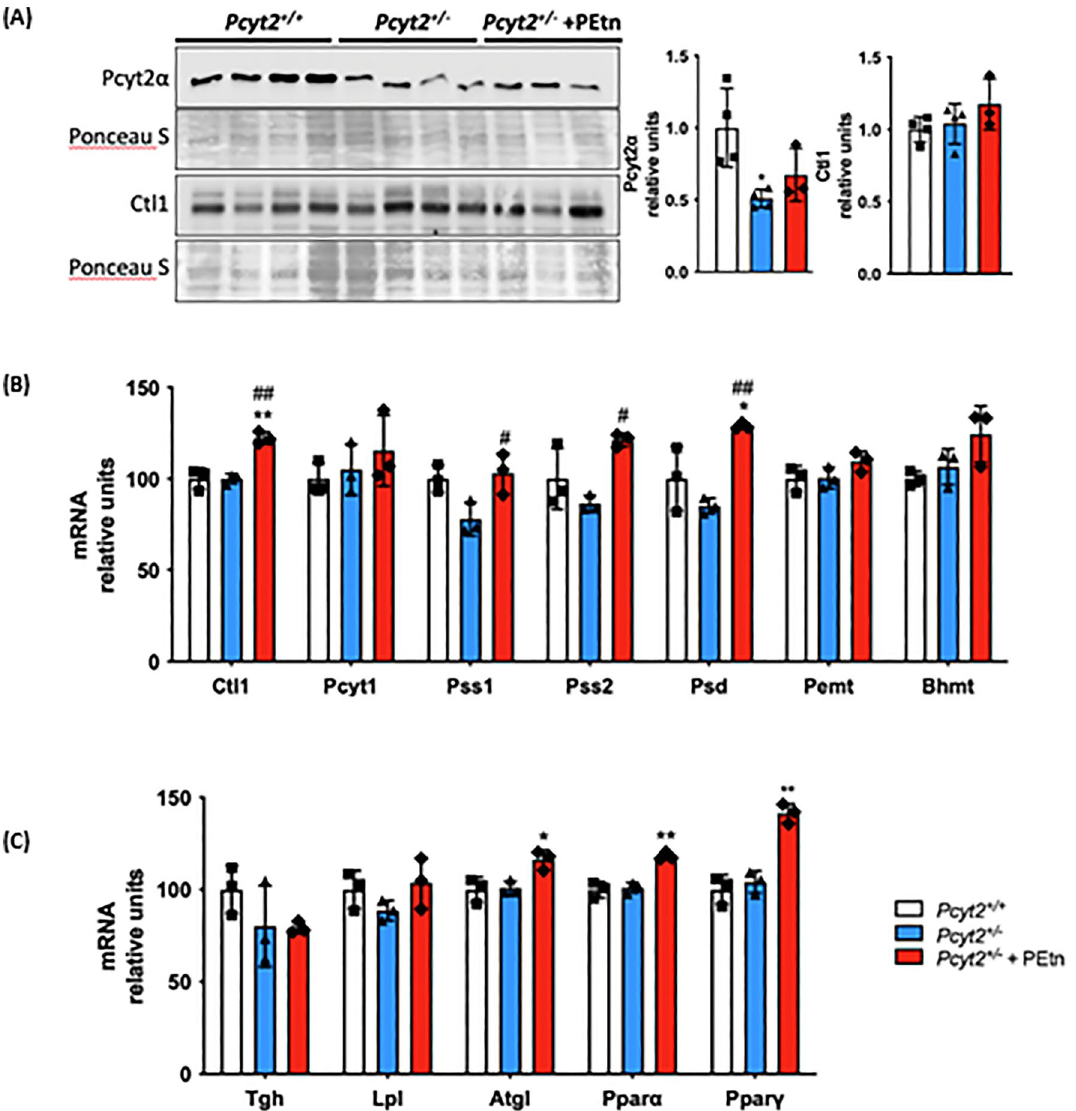
Figure 4. PEtn stimulates phospholipid and triglyceride metabolic genes. ( A ) Immunoblot analysis of liver Pcyt2α and Ctl1 in 8-mo Pcyt2 + / + , Pcyt2 + /− and Pcyt2 + /− + PEtn mice treated for 12 weeks (n = 3–4). mRNA analysis of ( B ) phospholipid and ( C ) lipid metabolism genes in Pcyt2 + / + , Pcyt2 + /− and Pcyt2 + /− + PEtn mice. GAPDH used as loading control. Band intensities were measured using ImageJ. Membranes were cut prior to antibody hybridization to allow for the probing of multiple targets on one membrane. Data are presented as mean ± SD. * p < 0.05, ** p < 0.01 relative to Pcyt2 + / + ; # p < 0.05, ## p < 0.01 relative to Pcyt2 + /−